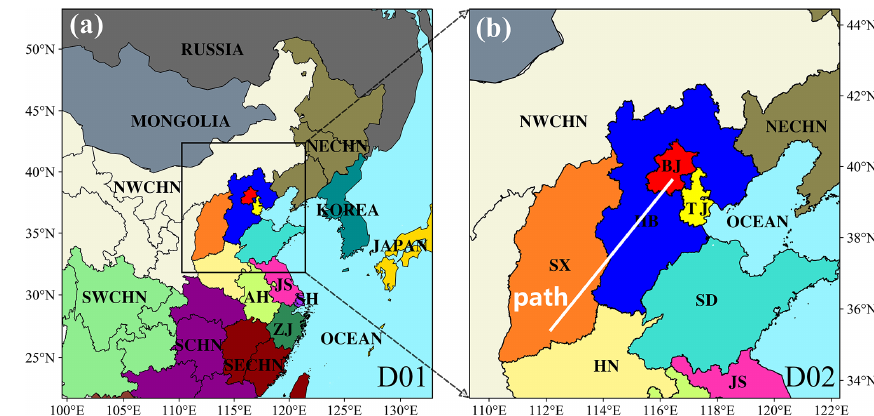
Figure 1. Model domain (the white line is the path of the vertical cross section in Sect.